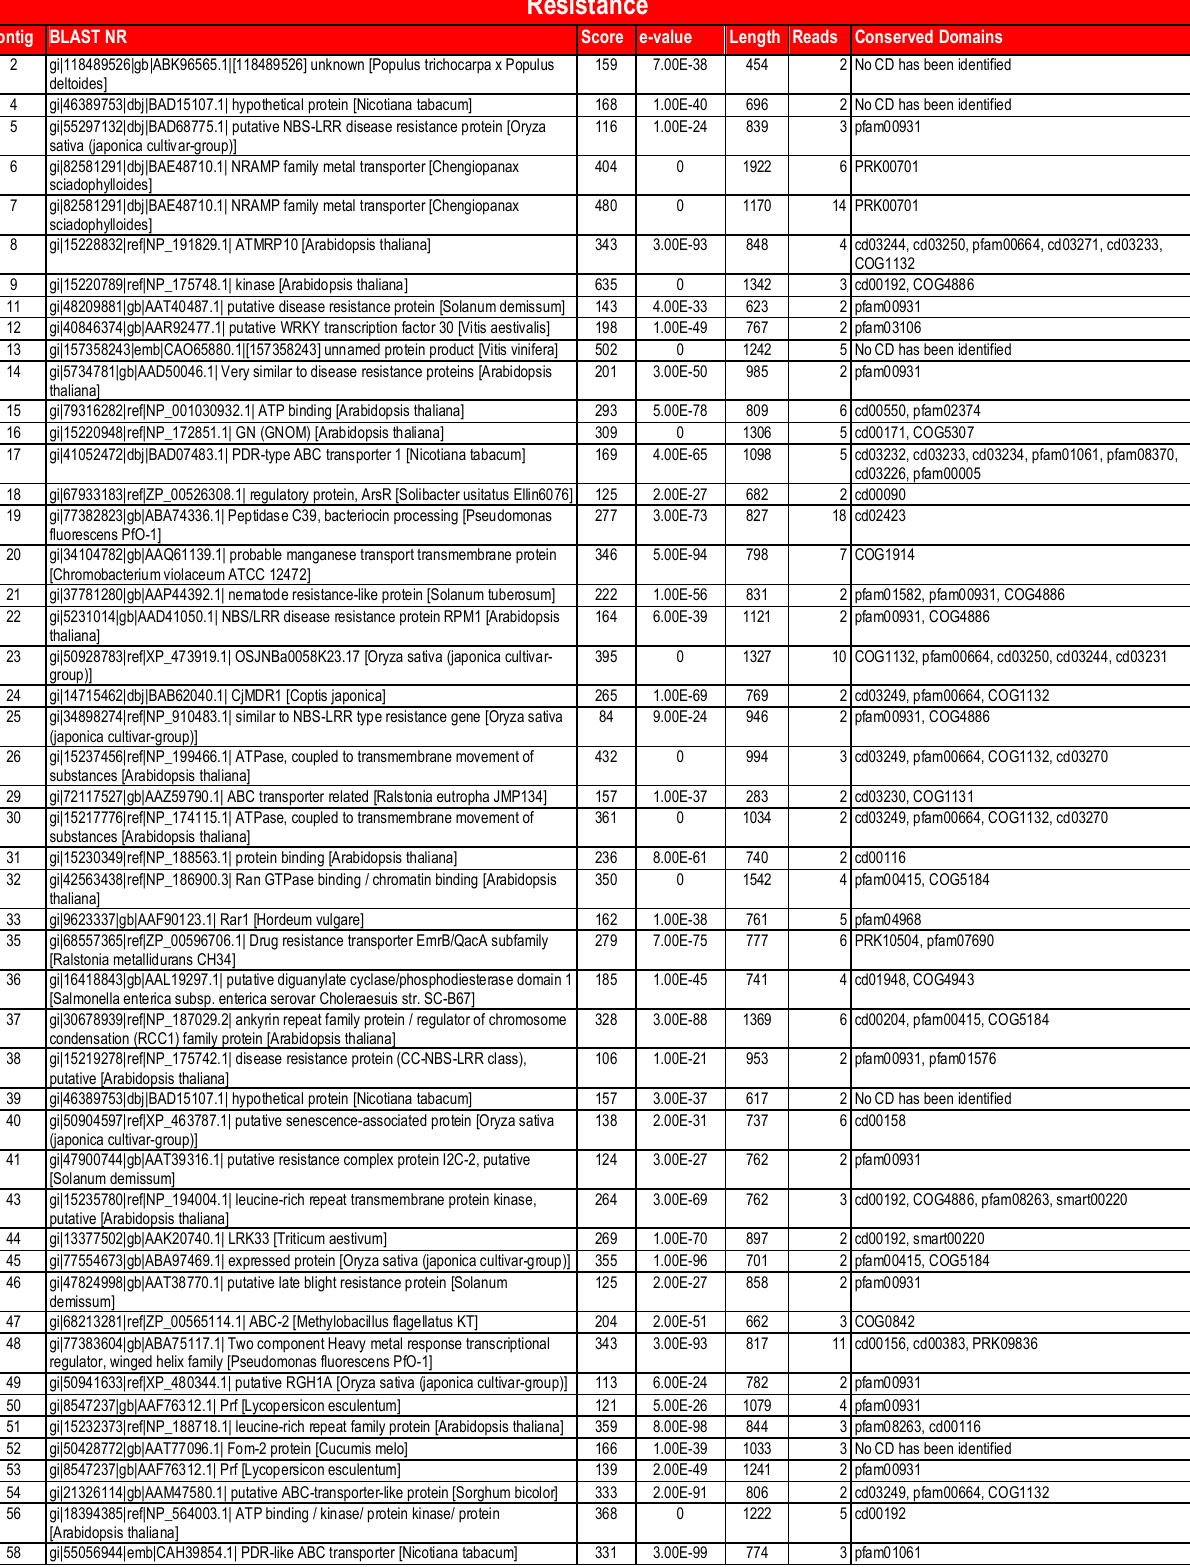
Table S2 : EST-Contigs with e-value < e -20 and score > 100 obtained in the Project Resistance, and their blast hit, score, e-value, size, number of reads, and conserved domains from putative